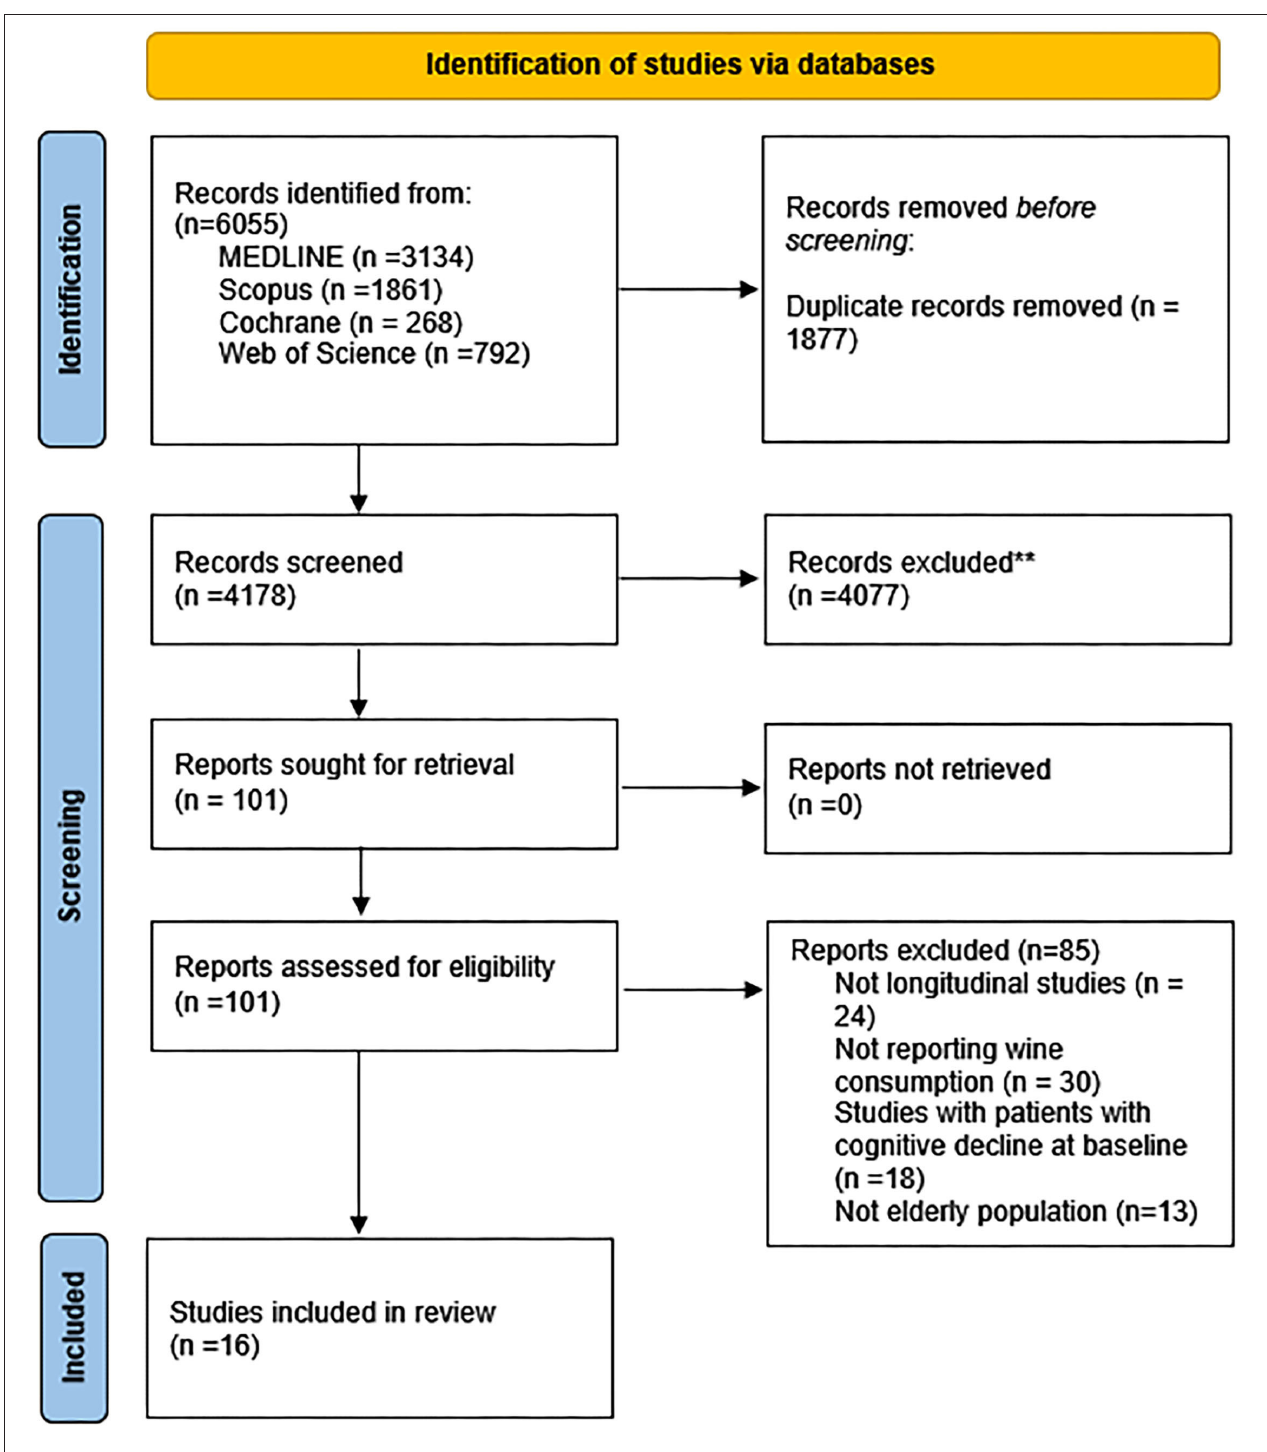
FIGURE 1 | PRISMA 2020 flow diagram for new systematic reviews which included searches of